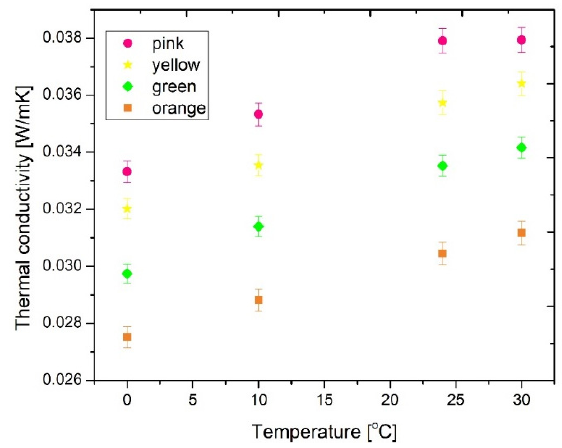
Figure 5. The measured thermal conductivities at different temperatures.